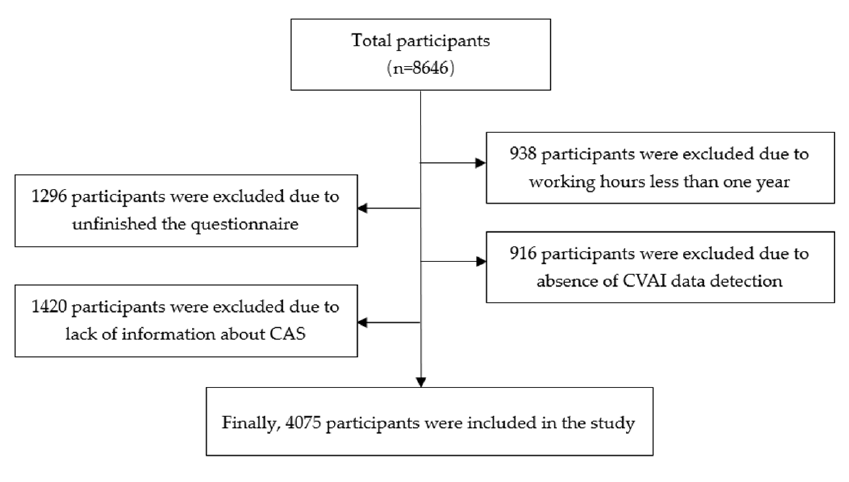
Figure 1. The process of study participants selection. CVAI: Chinese Visceral Adiposity Index, CAS: carotid atherosclerosis.